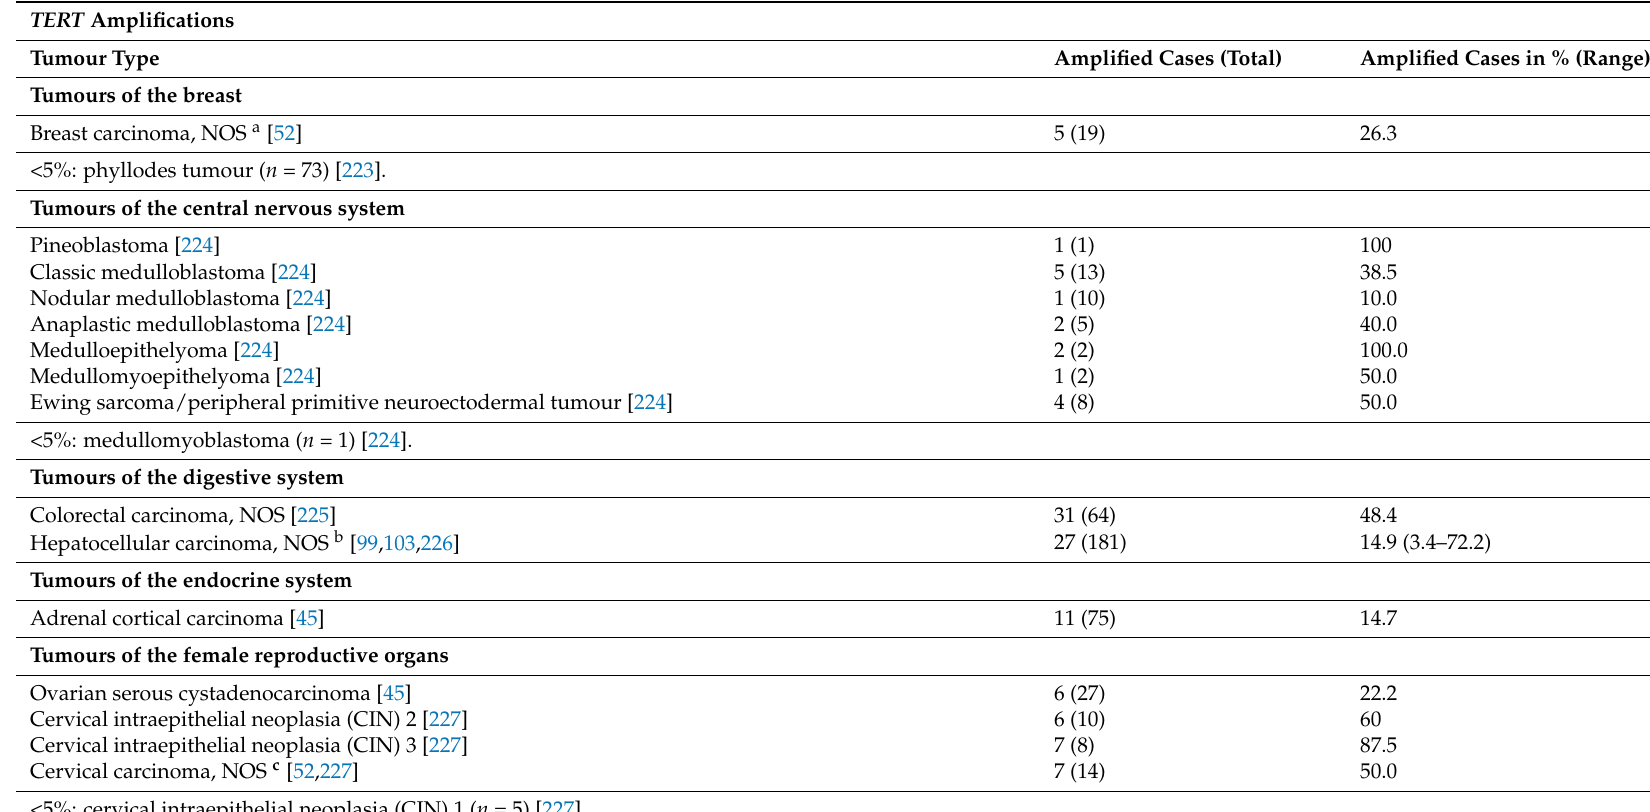
Table 2. Prevalence of TERT and TERC amplifications in human tumours. Only the tumour histotypes associated with a frequency of TERT and TERC amplifications ≥ 5% will appear in the following table together with its respective number, percentage, and range of mutated cases. Whenever the tumour histotypes were associated with a low rate of TERT and TERC amplifications (<5%) only the total of patients will be shown (complete data available in Supplementary Table S1); the percentages of amplified cases here presented are the same reported by its respective authors, therefore the readers should note that the applied cut-off of copy number alterations may vary among